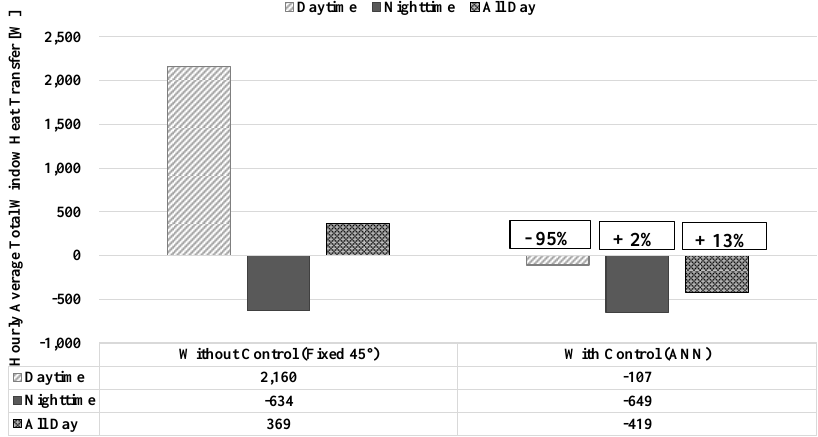
Figure 12. Hourly average total window heat transfer during the heating period.